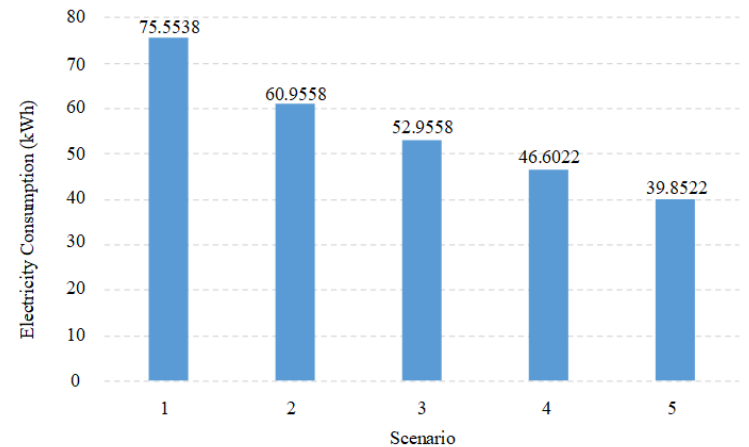
Figure 2. Electricity consumption of the Biochrom 30+ amino acid analyzer physiological system with the average HVAC system power rating.